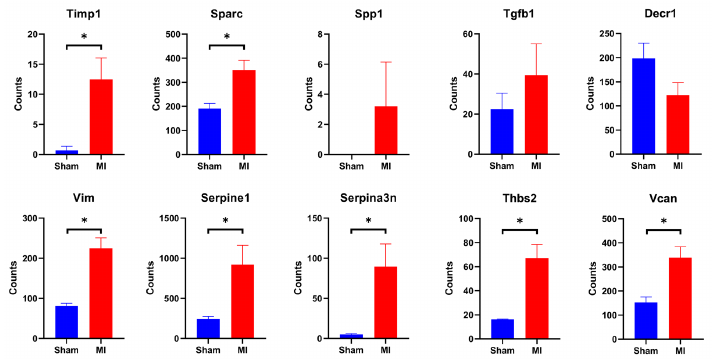
Figure 5. Hub gene expression in cardiomyocytes. MI indicates infarction surgery group, Sham indicates sham surgery group. Error lines indicate SEM. * p < 0.05, Mann-Whitney U test.